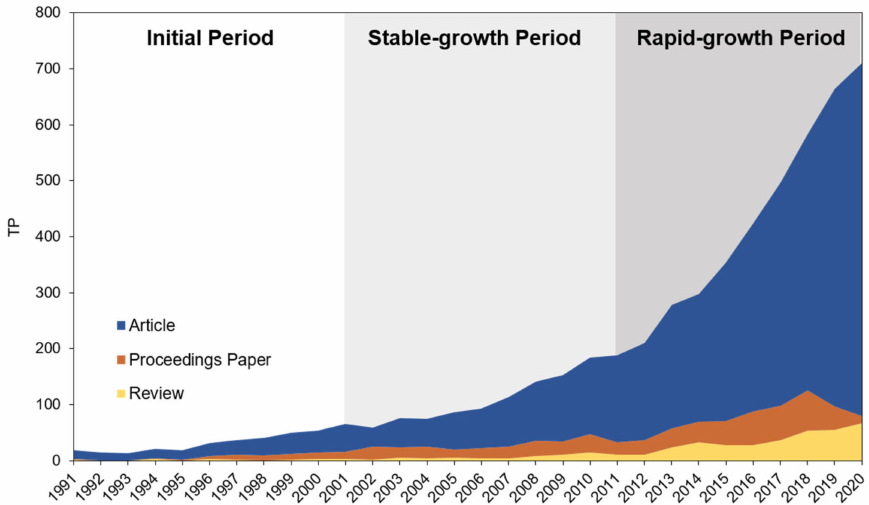
Figure 2. Publishing trend in the area of